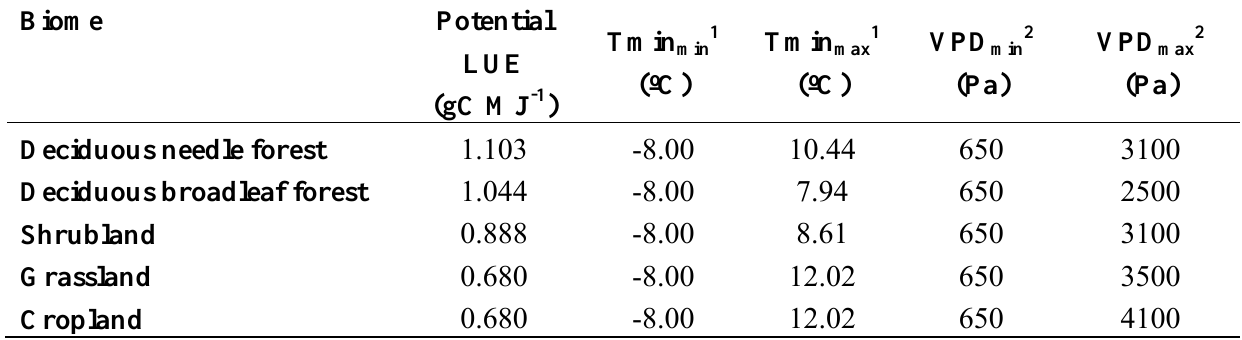
Table 1. Biome Look Up Table for calculation of potential light use efficiency to actual